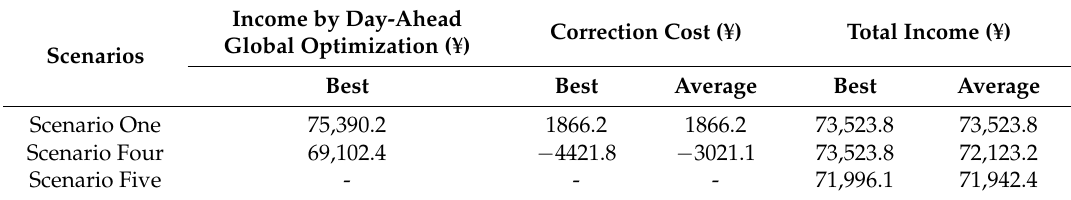
Table 2. The total income in in Scenario One, Four, and Five using the two-step optimization framework.